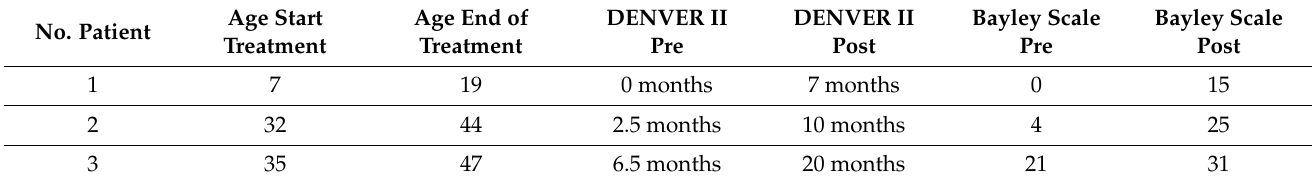
Table 3. Summary of intervention and results.